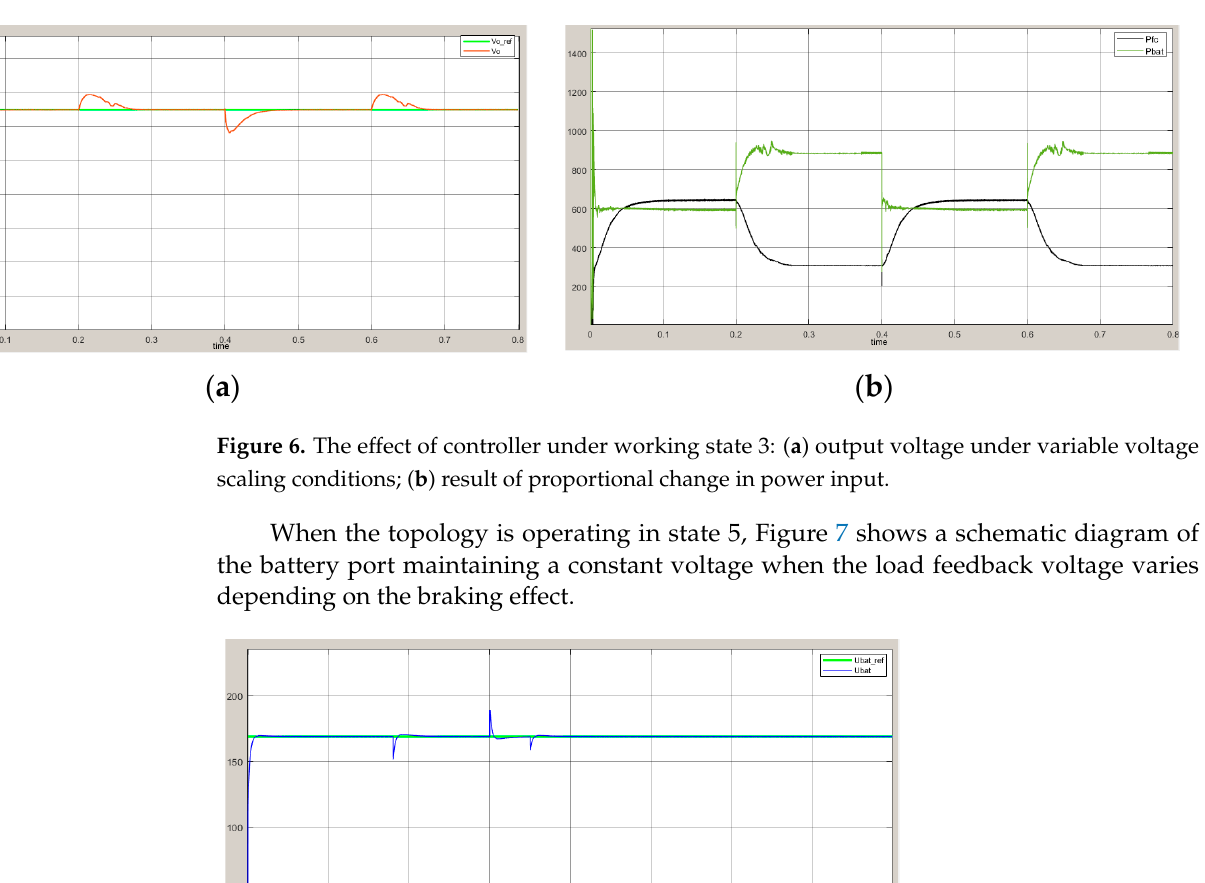
Table 1. Comparison of the proposed integrated converter topology with other on-board converters.